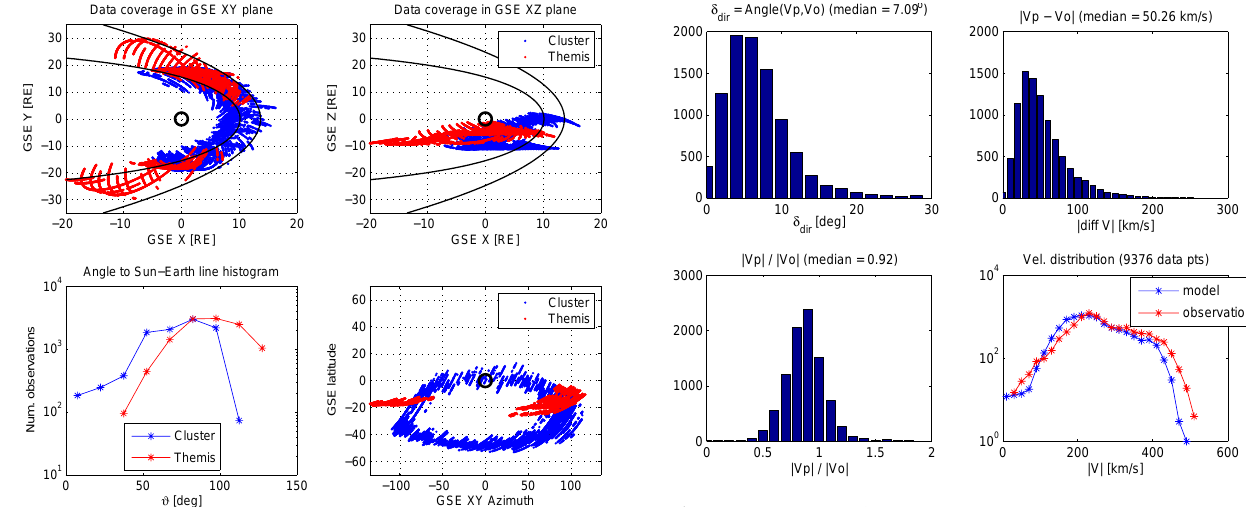
Fig. 6. Comparison of the predicted flow velocity with Cluster ob- servations. Top left: histogram of the angle δ dir between model and observed velocities. Top right: histogram of the magnitude of vector difference | V p − V o | . Bottom left: histogram of the ratio of magni- tudes V p /V o . Bottom right: distribution of predicted and observed velocity magnitudes V p (blue) and V o